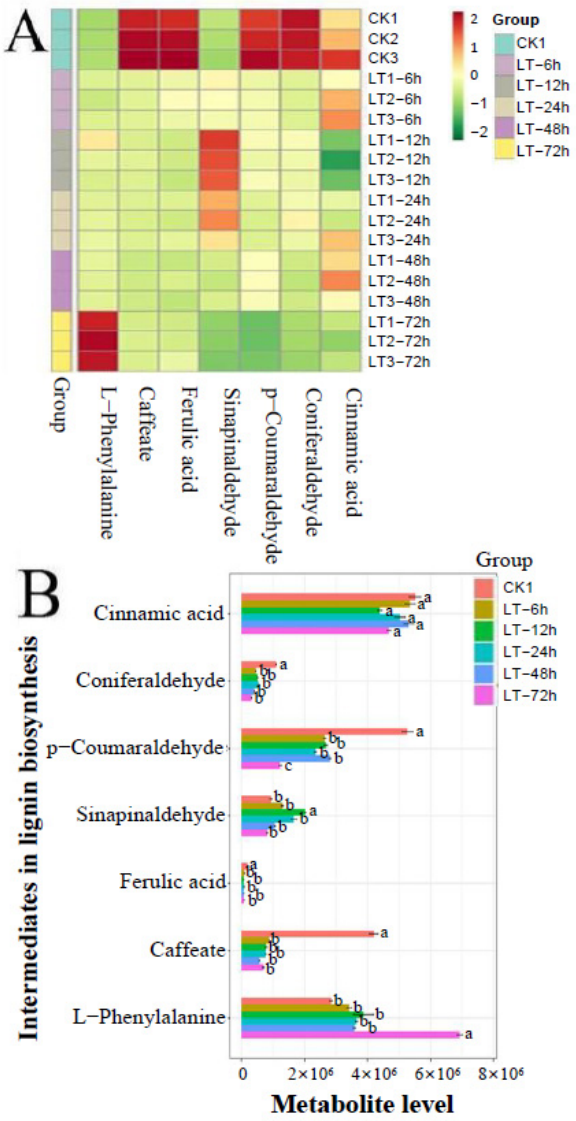
Figure 2. Analysis of intermediates in the lignin pathway. ( A ) The heat map of intermediates in lignin metabolism of 0 (CK), 6, 12, 24, 48, and 72 h after treatment with cold. ( B ) Histogram of the level of lignin of 0 (CK), 6, 12, 24, 48, and 72 h after treatment with cold. The data that showed as the mean ± SE was repeated three times. The sample of 0 h was used as calibrator. LT, low temperature.